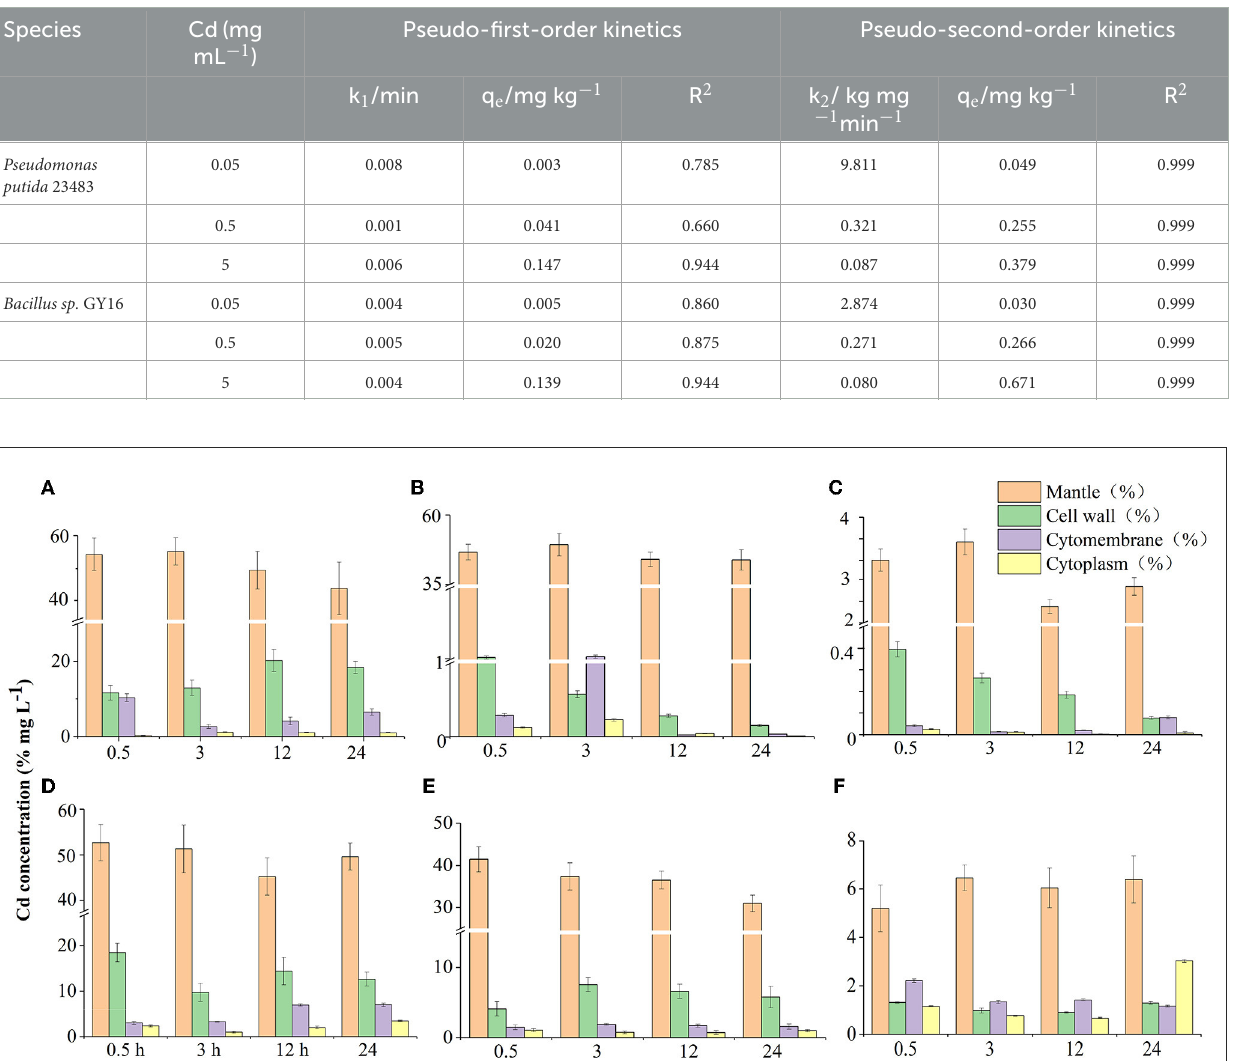
TABLE 1 Biosorption kinetic models for Cd of Pseudomonas putida 23483 and Bacillus sp. GY16 under different concentrations of Cd ions.